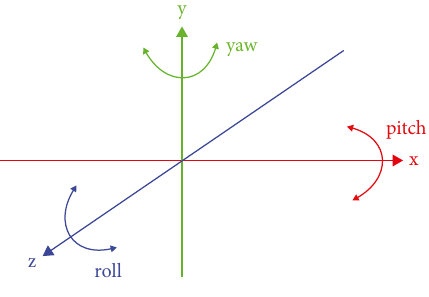
Figure 2: Six degrees of